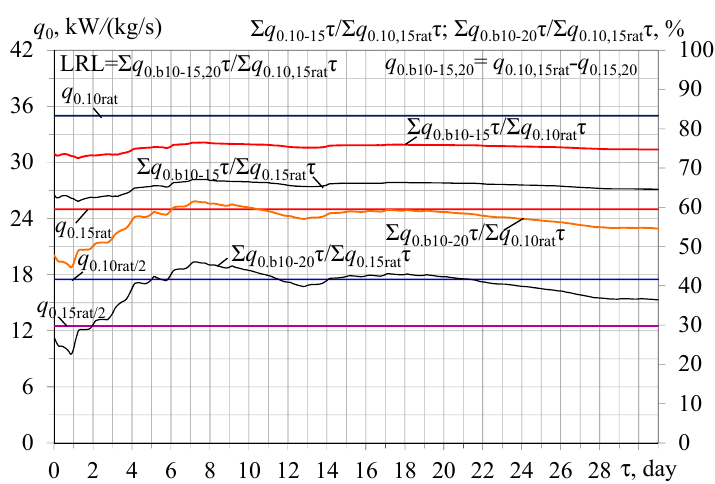
Figure 11. Values of relative summarized booster refrigeration energy ∑ ( q 0.b10-15 τ )/ ∑ ( q 0.10rat τ ) and ∑ ( q 0.b10-20 τ )/ ∑ ( q 0.10rat τ ) available for conditioning air to 15 ° С and 20 ° С , reduced summarized refrig- eration energy ∑ ( q 0.b10-15rat τ )/ ∑ ( q 0.15rat τ ) and ∑ ( q 0.b10-20.rat15 τ )/ ∑ ( q 0.15rat τ ), generated according to reduced value of design refrigeration capacity q 0.15red = q 0.15rat .